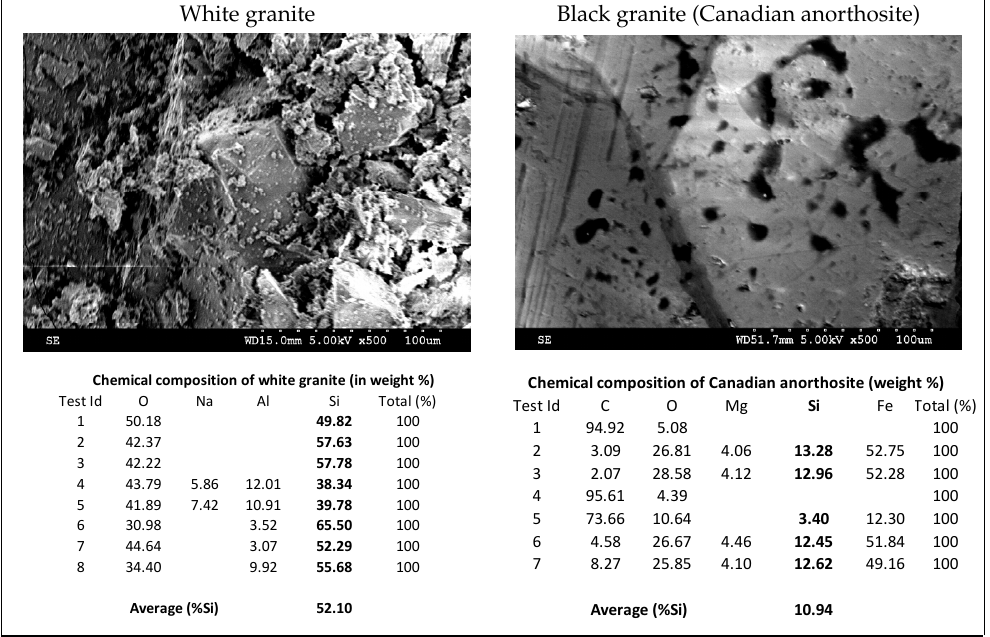
Table 1. Chemical composition from EDX of the two tested stones (Kouam et al. [26]). White granite